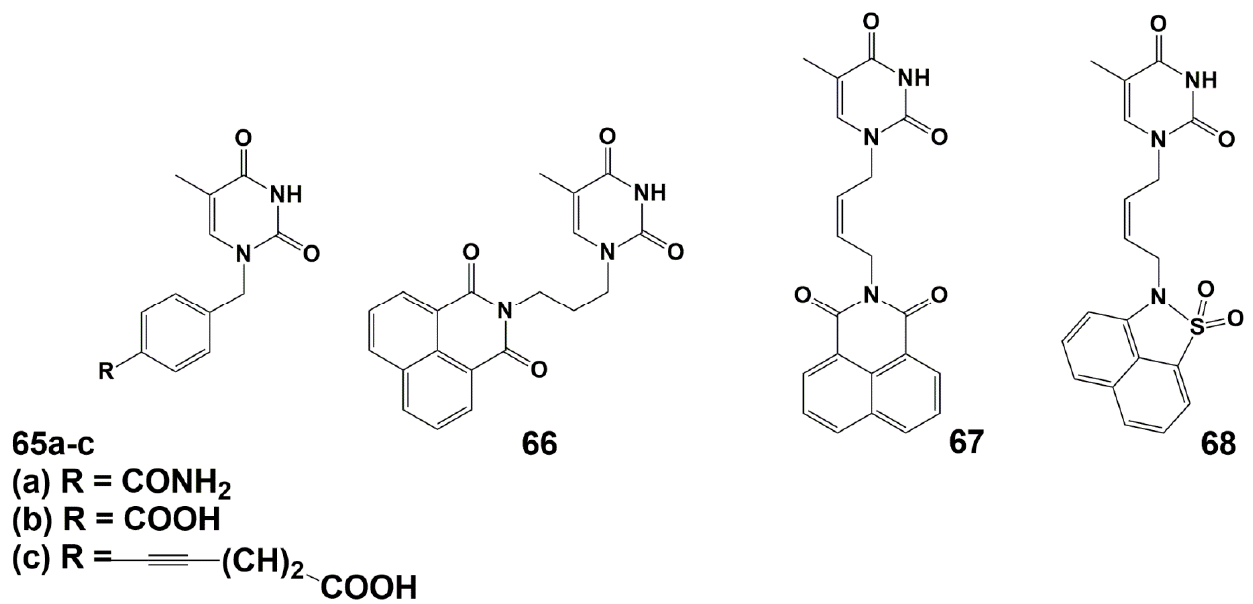
Figure 16. Arylpyrimidine inhibitors of TMPK mtb 65 – 68